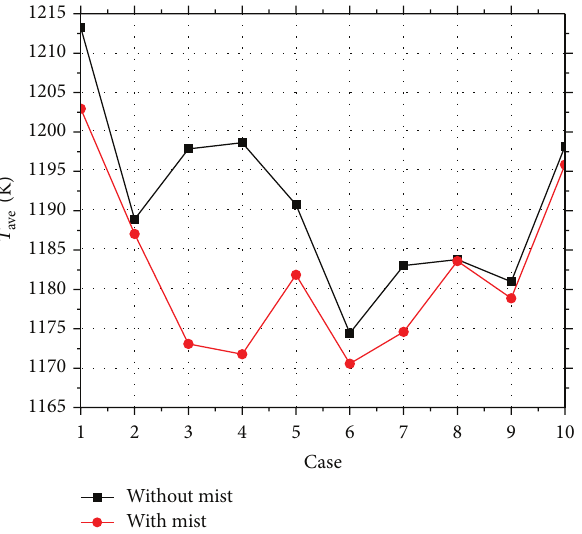
value in different cases with or ave